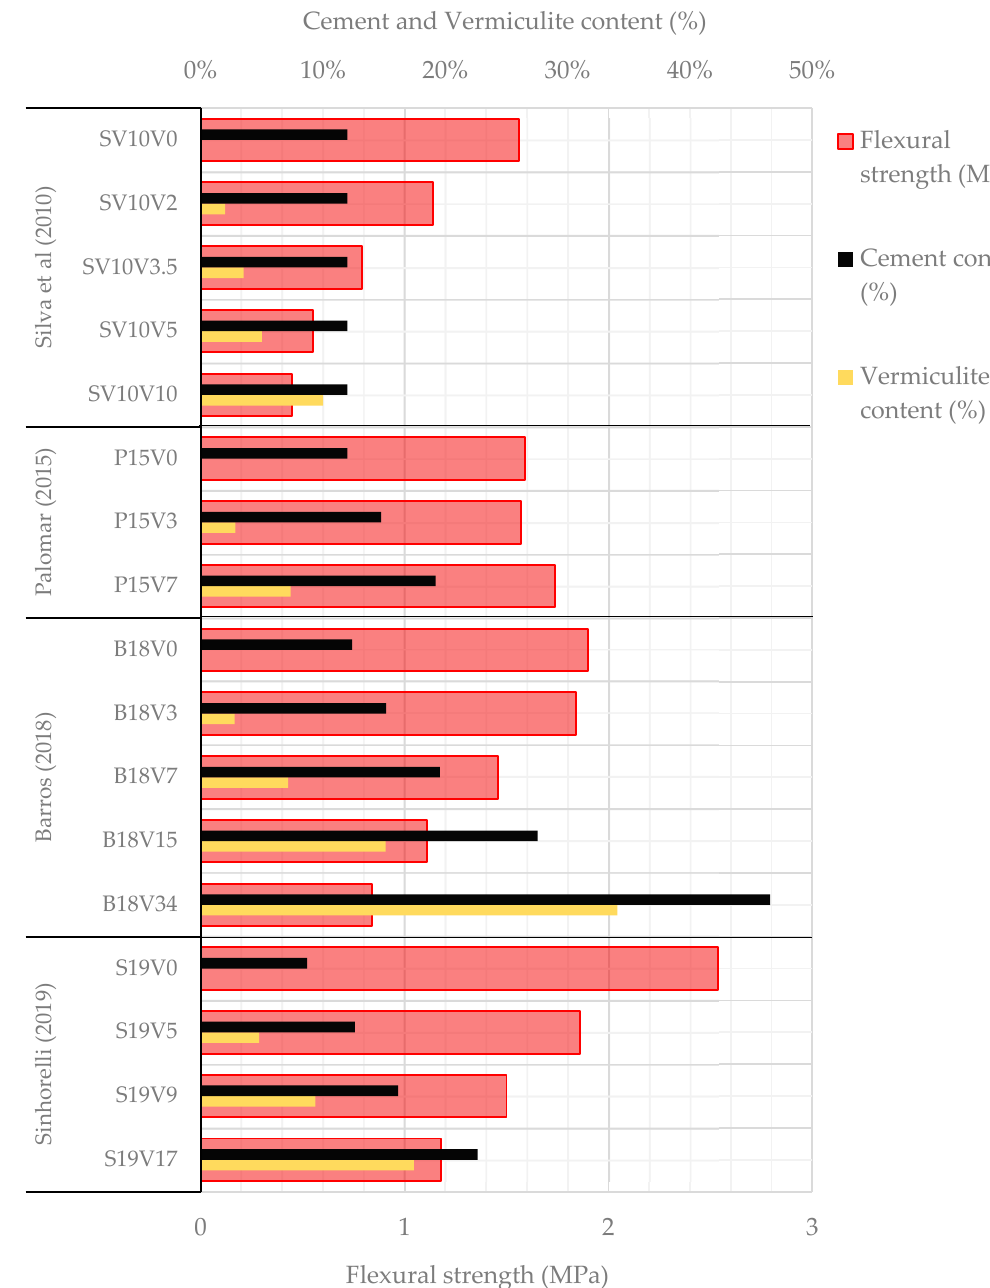
Figure 10. Correlation of the flexural strength values and cement and vermiculite content of the studied articles [17,41,44,45].